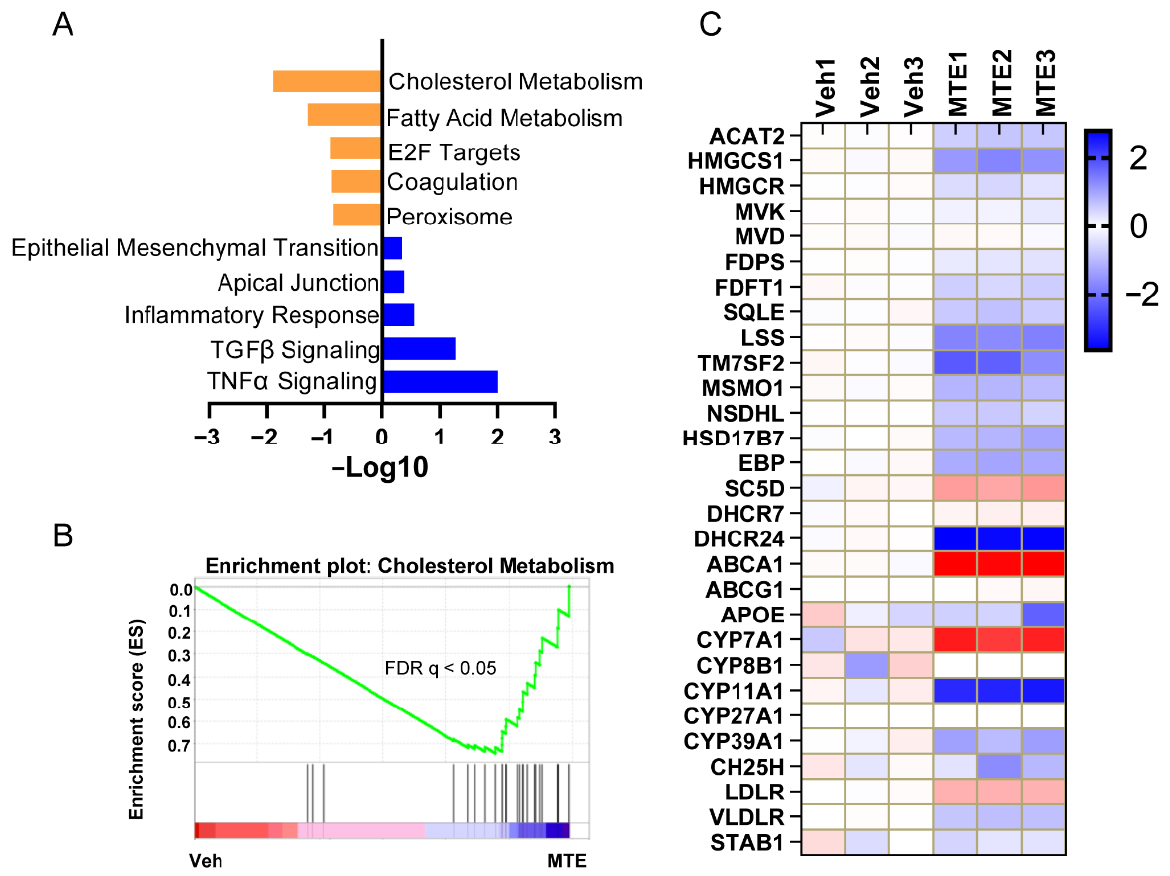
Figure 2. Cholesterol metabolism is susceptible to mycotoxin exposure. ( A ) Differences in activity scores of indicated pathway gene expressions using gene ontology analysis between the Control and the mycotoxin-treated IPEC − J2 cells. ( B ) GSEA plots depicting the enrichment of genes down-regulated in the cholesterol metabolism pathway in porcine IPEC − J2 cells treated by mycotoxin. FDR, false discovery rate. ( C ) Heat − map of the mRNA profile of core cholesterol-metabolism genes.